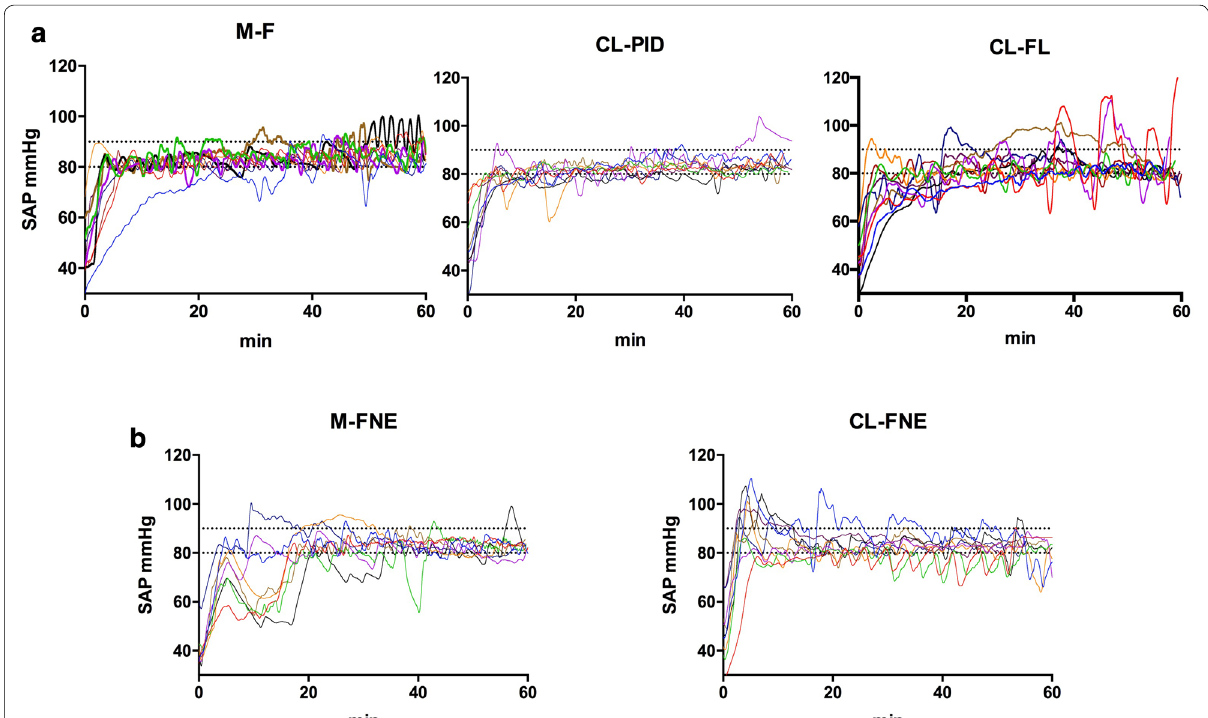
Fig. 3 Systolic arterial pressure (mmHg) over time in groups resuscitated with fluid ( a ) and in groups resuscitated with combination of fluid and norepinephrine ( b ). M-F manual fluid, CL-PI closed-loop fluid with a PI algorithm, CL-FL closed-loop fluid with a fuzzy logic algorithm, M F-NE manual fluid and norepinephrine, CL F-NE closed-loop fluid and norepinephrine